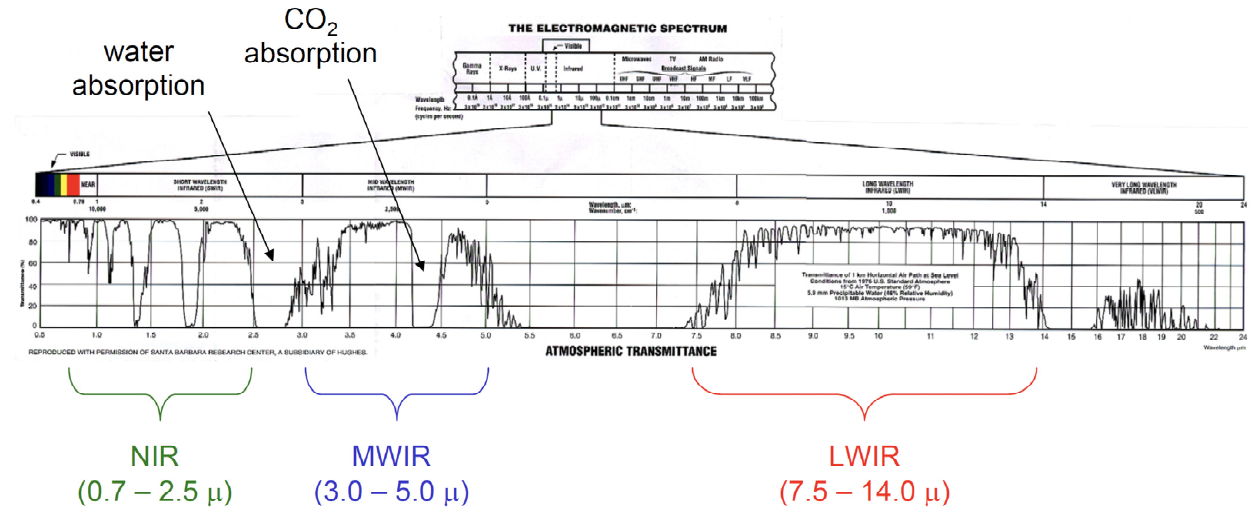
Figure 2. Infrared band atmospheric transmittance.